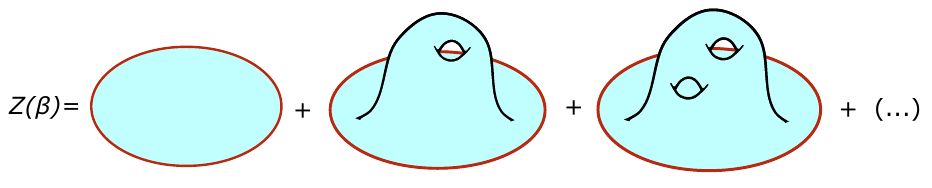
Figure 11 . A graphical representation of formula